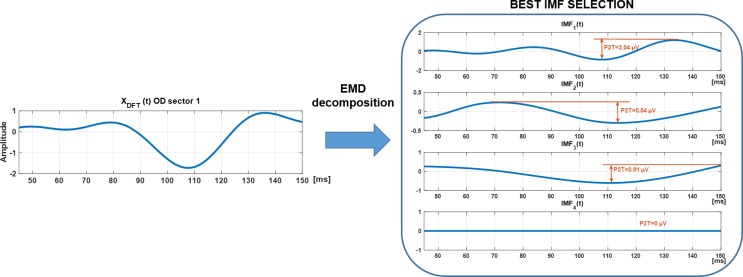
Example of Best IMF selection (OD, sector 1).Highest P2T values is presented in IMF1 so this one is selected as the Best IMF.